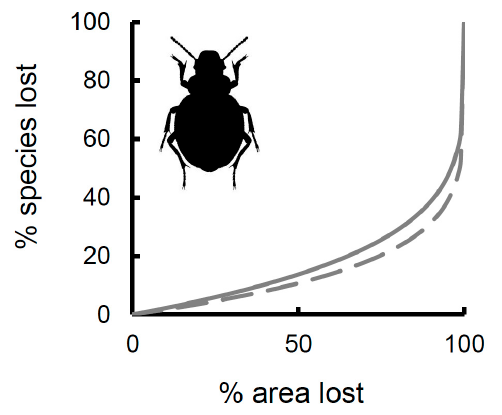
Figure 5. Extinction rates (% of extinct species) expected on the basis of area reduction (% of area lost) for tenebrionids in Italian reserves. Solid line: expected rate from the species-area relationship. Dashed line: expected rate from multiple regression models.